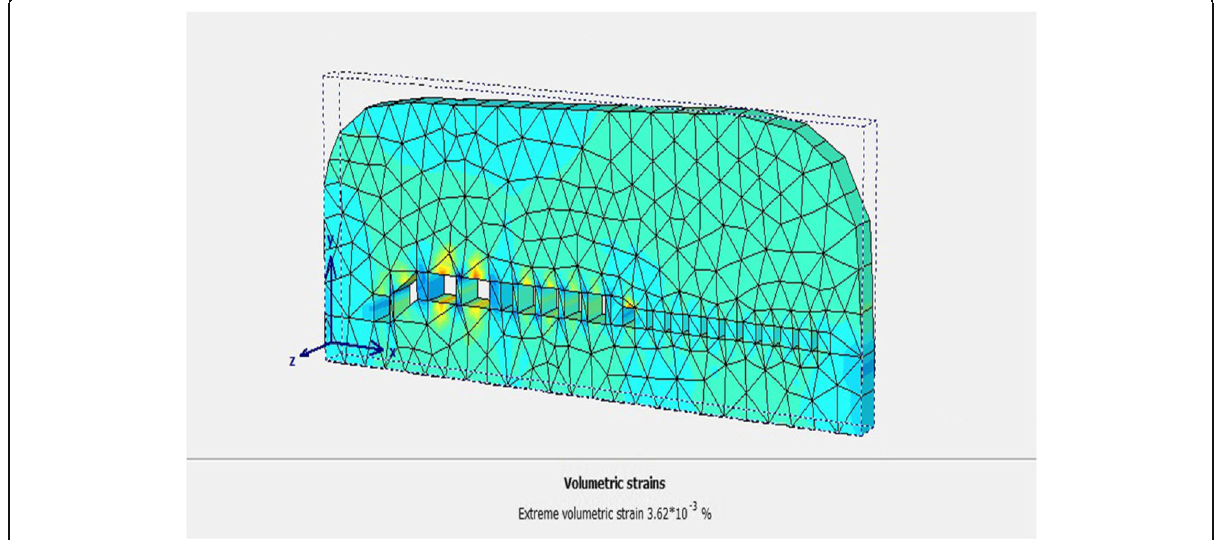
Fig. 26 Volumetric strains of rock pillars in Chamber 3and others small burial